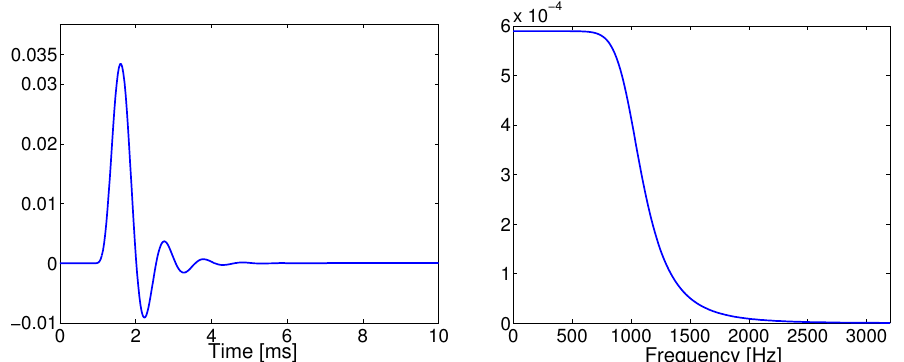
Figure 5. Source wavelet signal: wavelet in time domain ( left ) and direct Fourier transform of the wavelet showing the 1000Hz upper corner frequency ( right ).